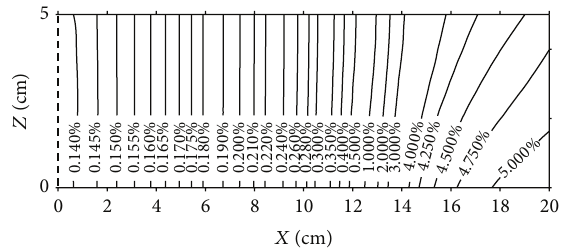
Figure 8: Moisture content distributions after 135 days.